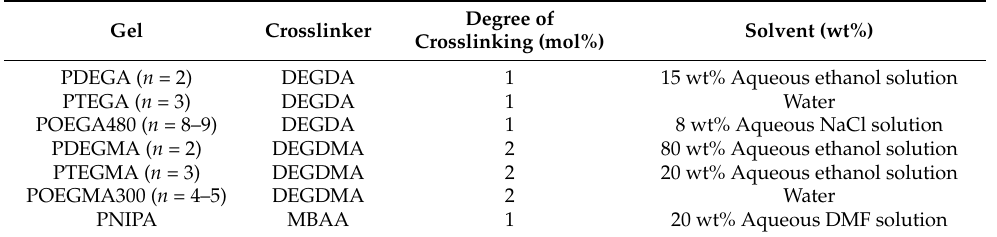
Table 1. Porous thermosensitive gels used in this study a .